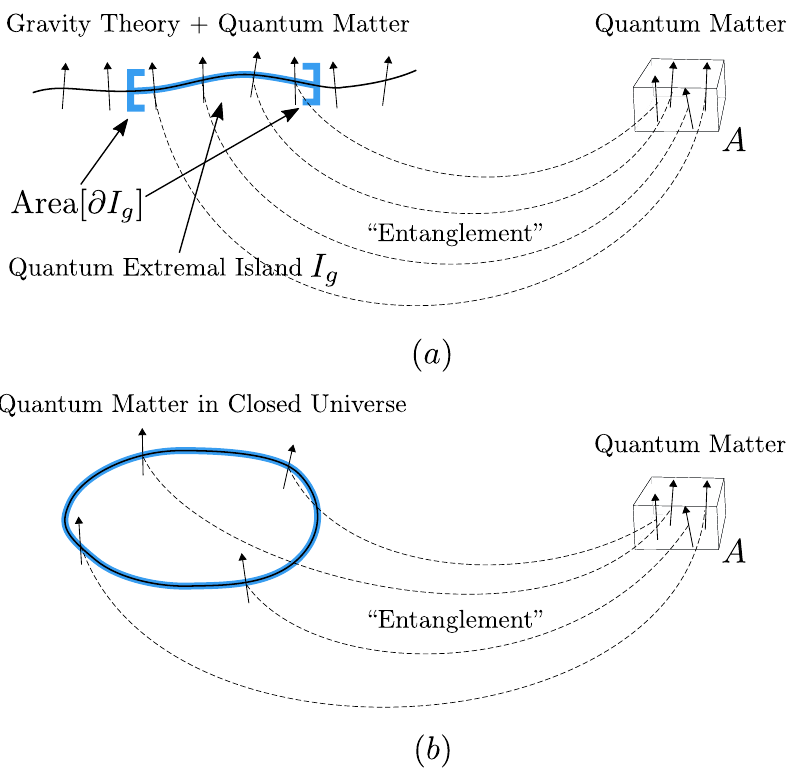
Figure 12 . On the left side we have a quantum system, A , entangled with quantum (cid:12)elds living in a dynamical geometry, which we take to have one spatial dimension. The rule is that we can consider islands, labelled here as blue regions I g . In (a) the region I g is a portion of the whole geometry which has a boundary with area Area( @ I g ). In (b) region I g is the whole universe and it has zero